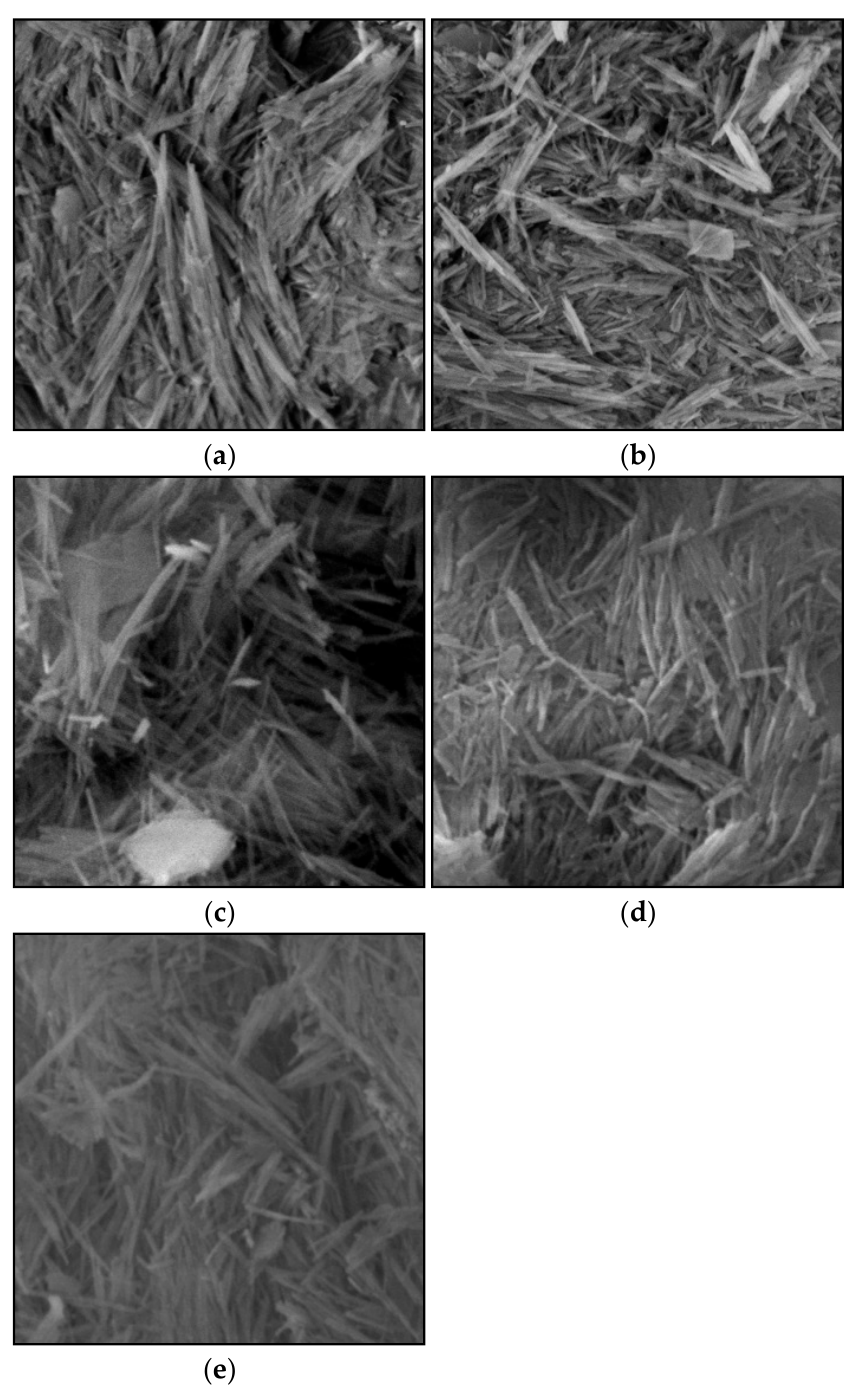
Figure 3. Micrographs of NAC by FESEM (1:10,000). ( a ) Raw ore; ( b ) High viscosity ore; ( c ) Calcined raw ore under 650 ◦ C; ( d ) Calcined high viscosity ore under 650 ◦ C; ( e ). Calcined high viscosity ore under 750 ◦ C